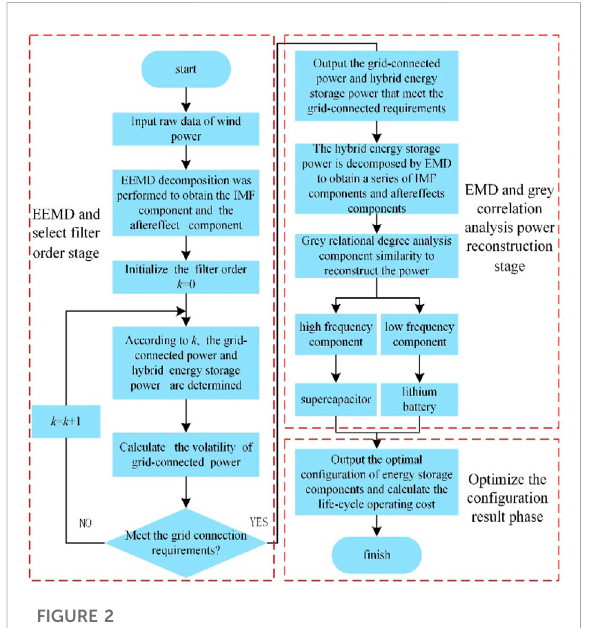
FIGURE 2 Flow chart of hybrid energy storage capacity optimization con fi guration algorithm.